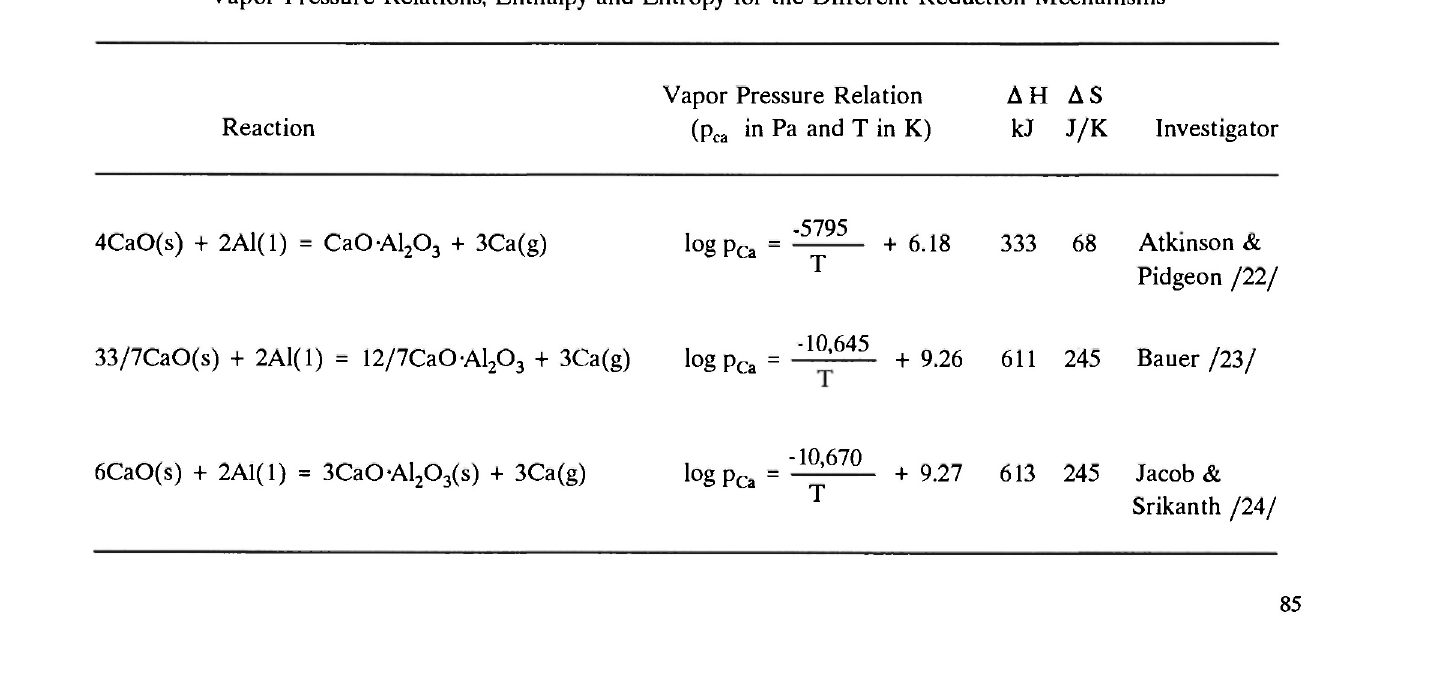
Vapor Pressure Relations, Enthalpy and Entropy for the Different Reduction Mechanisms